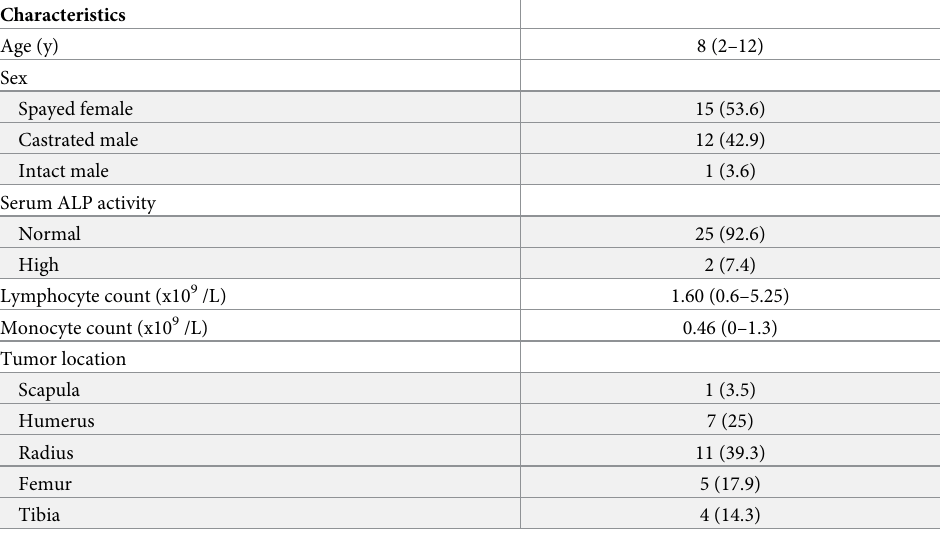
Data are reported as median (range) for age, lymphocyte, and monocyte count, and number (%) of dogs in category for sex, serum ALP activity (relative to reference range), and tumor